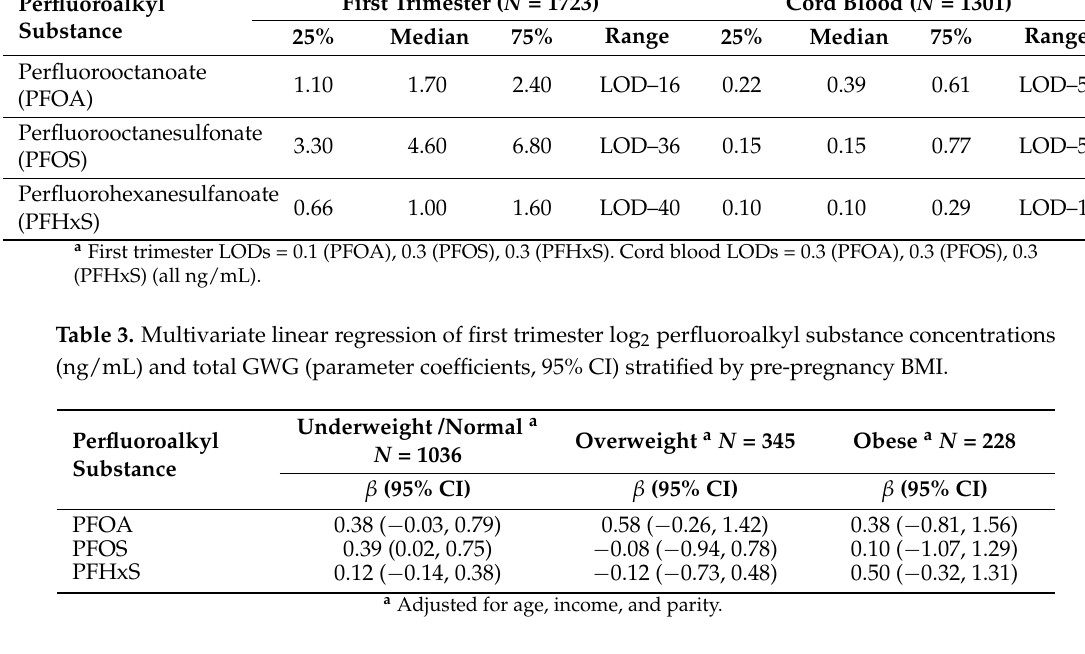
Table 4. Logistic regression analysis of association between GWG (continuous) and binary measures of cord blood perfluoroalkyl substances concentrations per 1 kg and interquartile range increase in